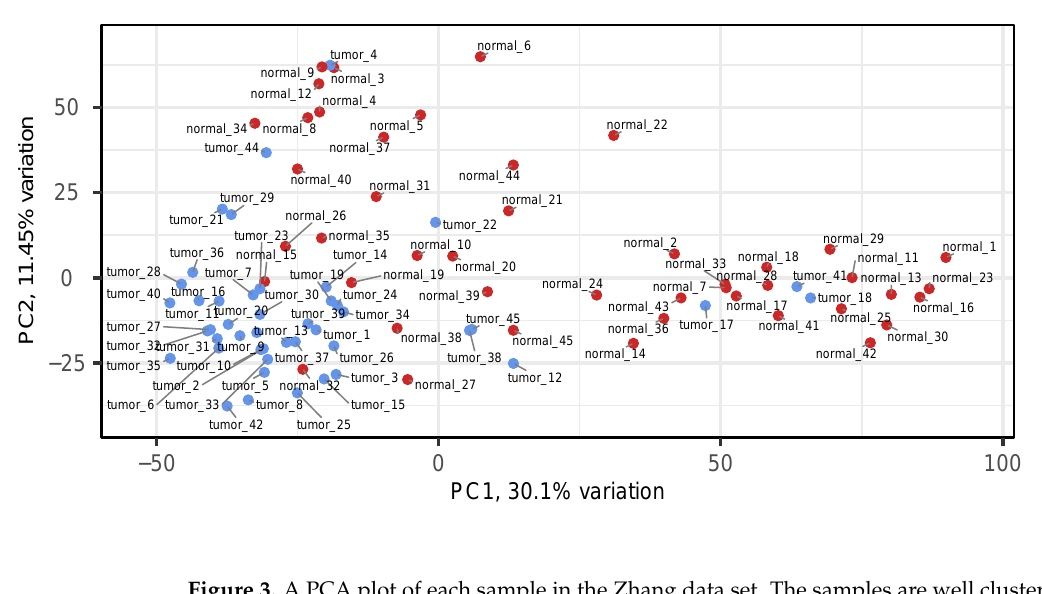
Figure 3. A PCA plot of each sample in the Zhang data set. The samples are well clustered according to their different sample status (tumor or normal) and no other effect seems to be present. Data taken from the Zhang data set.